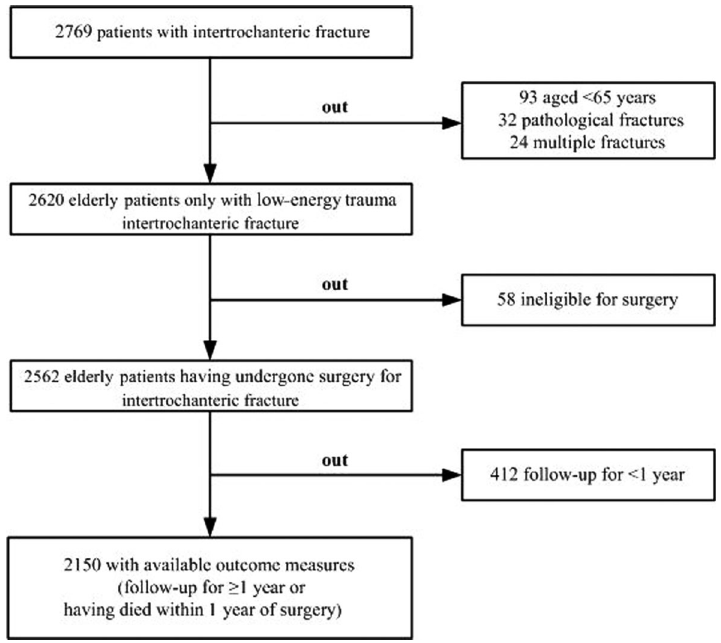
Figure 1. Stepwise selection of